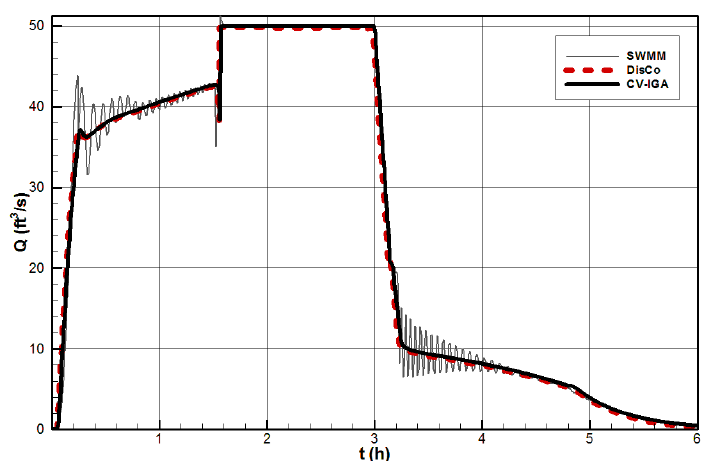
Figure 5. Hydrograph: comparison between SWMM [56], DisCo [25], and CV-IGA (the present